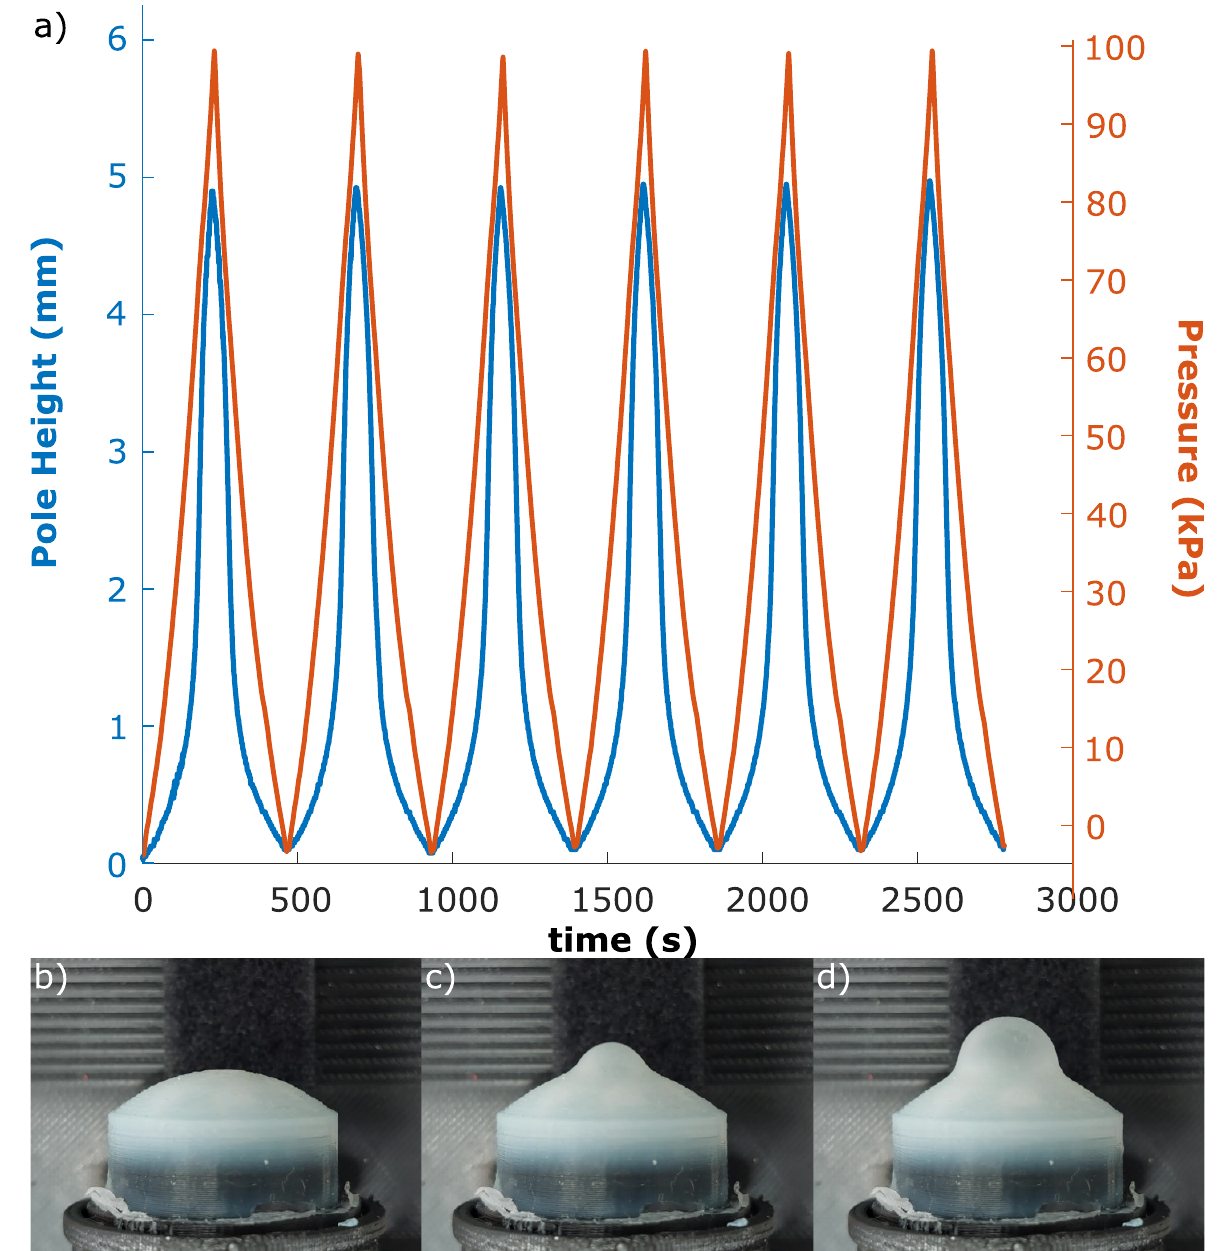
Figure 7. ( a ) Synchronised optical tracking and pressure data for six repeated cycles between high and low pressure on a 2.5 mm membrane. The similarity of the cycles indicates that the response is repeatable. ( b ) Low, ( c ) medium, and ( d ) high pressure state stills of a 2.5 mm